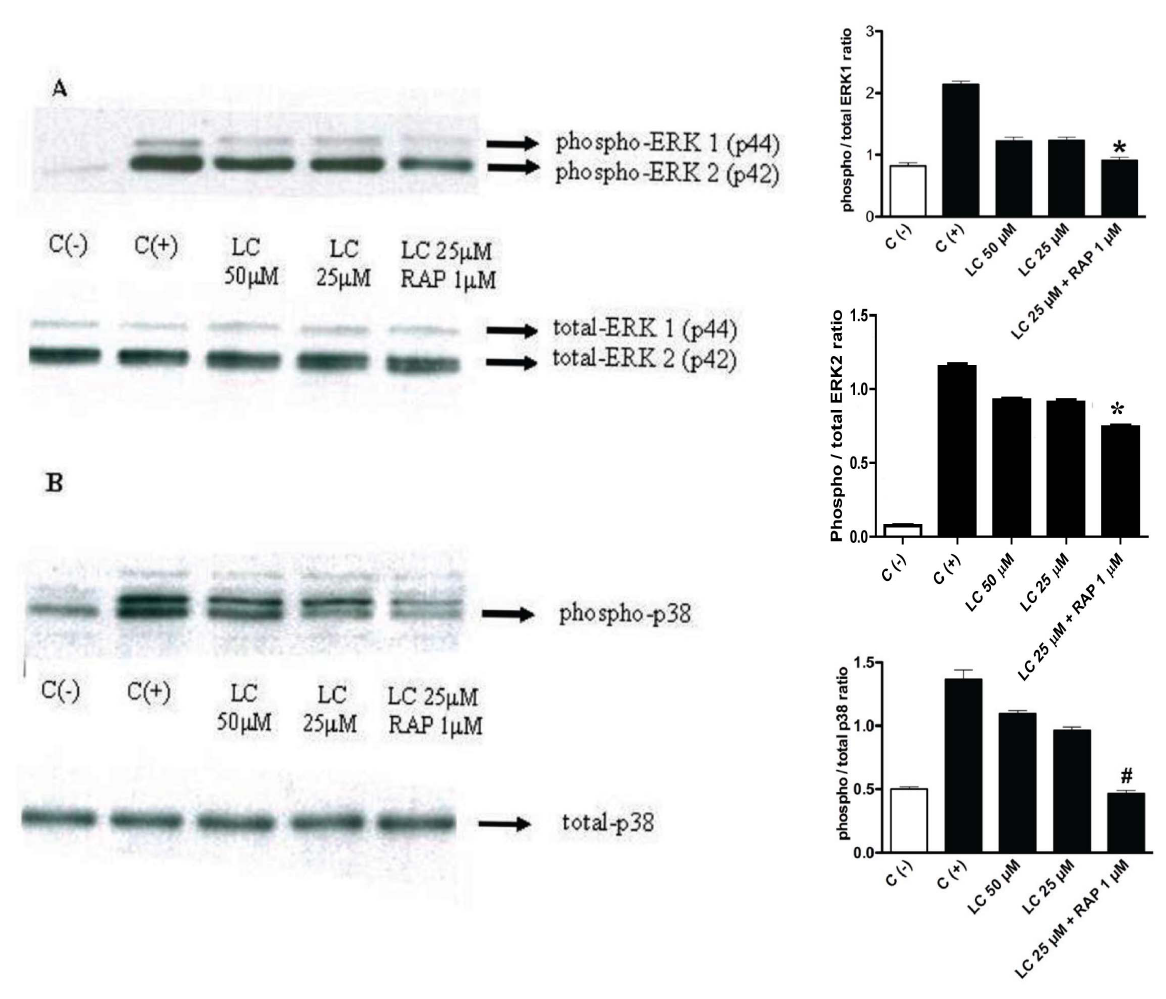
Figure 4. Effect of LCs on ERK1/2 and p38 MAPK (immunoblots on the left side of the panel with corresponding bar graphs of densitometric measurements next to each immunoblot panel. Panel A shows inhibition of light chain (LC)-stimulated phosphorylation of ERK K , and panel B , inhibition of phosphorylation of p38 MAPK by RAP pretreatment. After 1-h pretreatment with 1 m M RAP human proximal tubule cells were exposed to LC for 4 h (representative blots from 3 different experiments are shown; ‘‘C ( 2 )’’=negative control; ‘‘C ( + )’’=positive control; bars represent mean 6 SE of three densitometric readings). A : Effect of RAP pretreatment on LC-induced activation of ERK1/2. Cells were pretreated with RAP for 1 h and then treated with LC in the continued presence of RAP for 4 h. Top : RAP inhibited LC-induced activation of ERK1/2 (LC 25 m M + RAP 1 m M vs. positive control, C ( + ), *P , 0.001; LC 25 m M + RAP 1 m M vs. LC 25 m M alone, P , 0.05; LC 25 m M + RAP 1 m M vs. LC 50 m M alone, P , 0.01; LC 25 m M + RAP 1 m M compared to negative control, C ( 2 ), P . 0.05, Newman-Keuls Multiple Comparison Test). Bottom : Total ERK was not affected. B : Effect of RAP pretreatment on LC-induced activation of p38 MAPK. Top: LC-induced activation of p38 was suppressed by RAP (LC 25 m M + RAP 1 m M vs. C ( + ), P , 0.001; LC 25 m M + RAP 1 m M vs. LC 50 m M alone, # P , 0.001. LC 25 m M + RAP 1 m M vs. LC 25 m M alone, P , 0.001; LC 25 m M + RAP 1 m M vs. C ( 2 ), P . 0.05, Newman-Keuls Multiple Comparison Test). Bottom : Total p38 was not affected (representative blots from 3 different experiments are